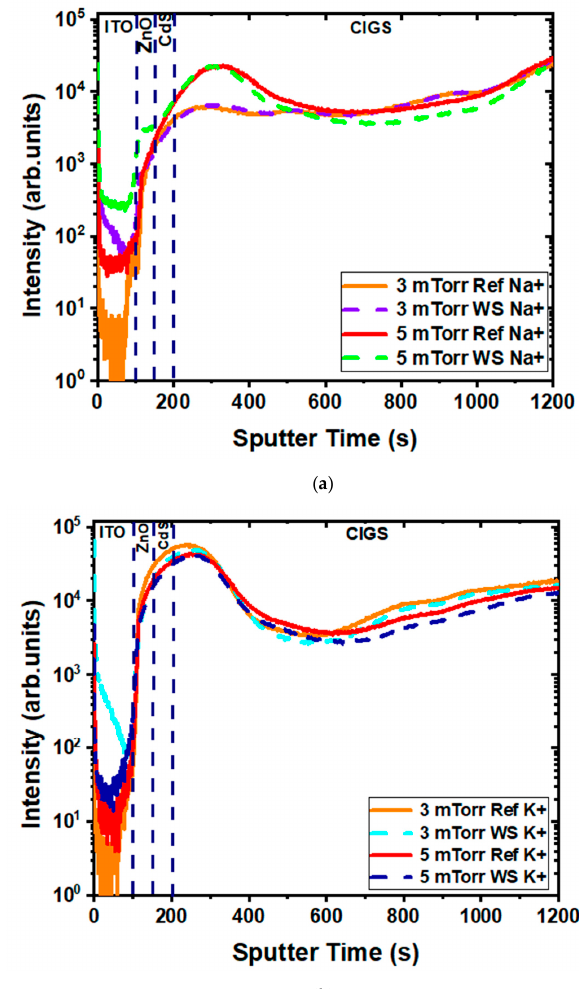
Figure 9. SIMS depth profiles of Na ⁺ ( a ) and K ⁺ ( b ) in the reference (solid) and 24 h water-soaked (dash) samples for the 3 mTorr and the 5 mTorr experimental set.